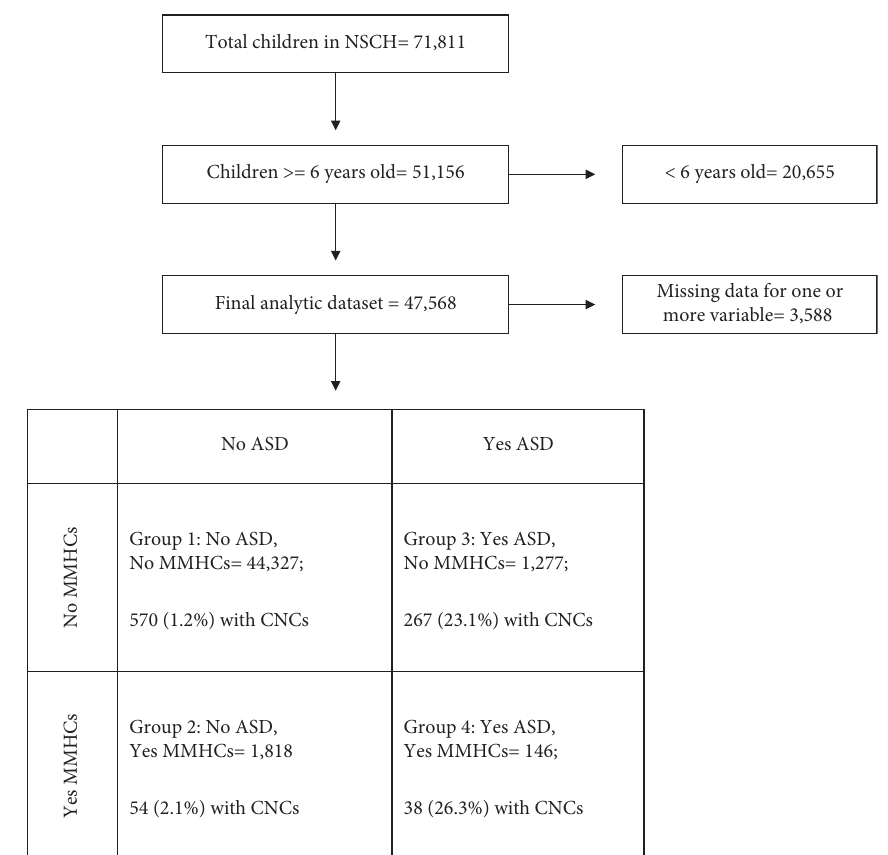
Figure 1: The four groups of the main variable formed based on current diagnosis of autism spectrum disorder (ASD) and presence of a maternal mental health condition (MMHC). The number and percent within each group who had one or more co-occurring neurological condition (CNC defined as intellectual disability, cerebral palsy, or epilepsy or seizure disorder) are also displayed.